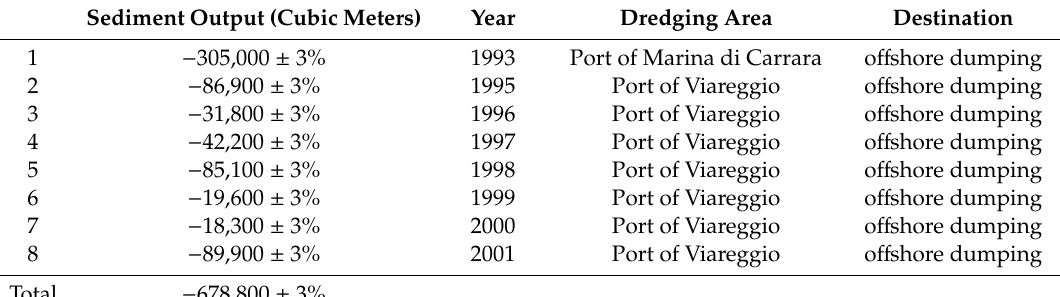
Table 3. Volume of sediments dredged from the harbor at Marina di Carrara and Viareggio and dumped o ff shore beyond the depth of closure in the 1980–2020 timespan along the considered sector of coast, sorted by the year of